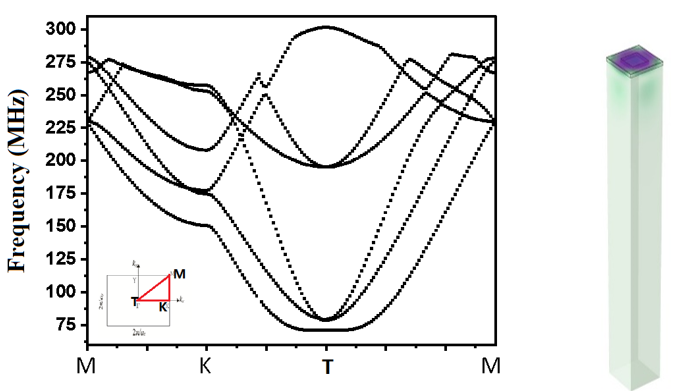
Figure 4. Band structure of Al/SiO 2 /36° LiTaO 3 and the typical eigen mode.